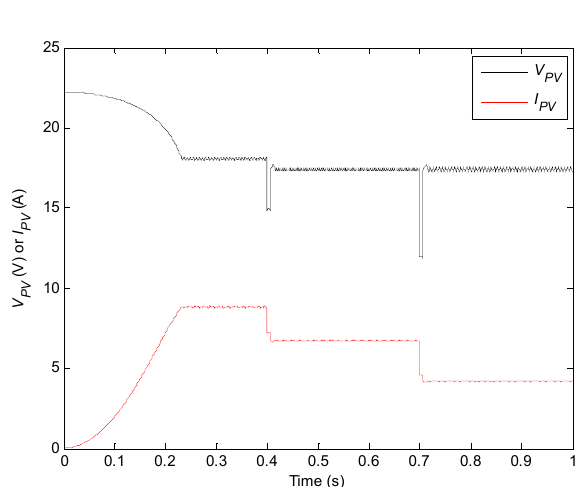
Figure 24. I PV curves in first simulation.